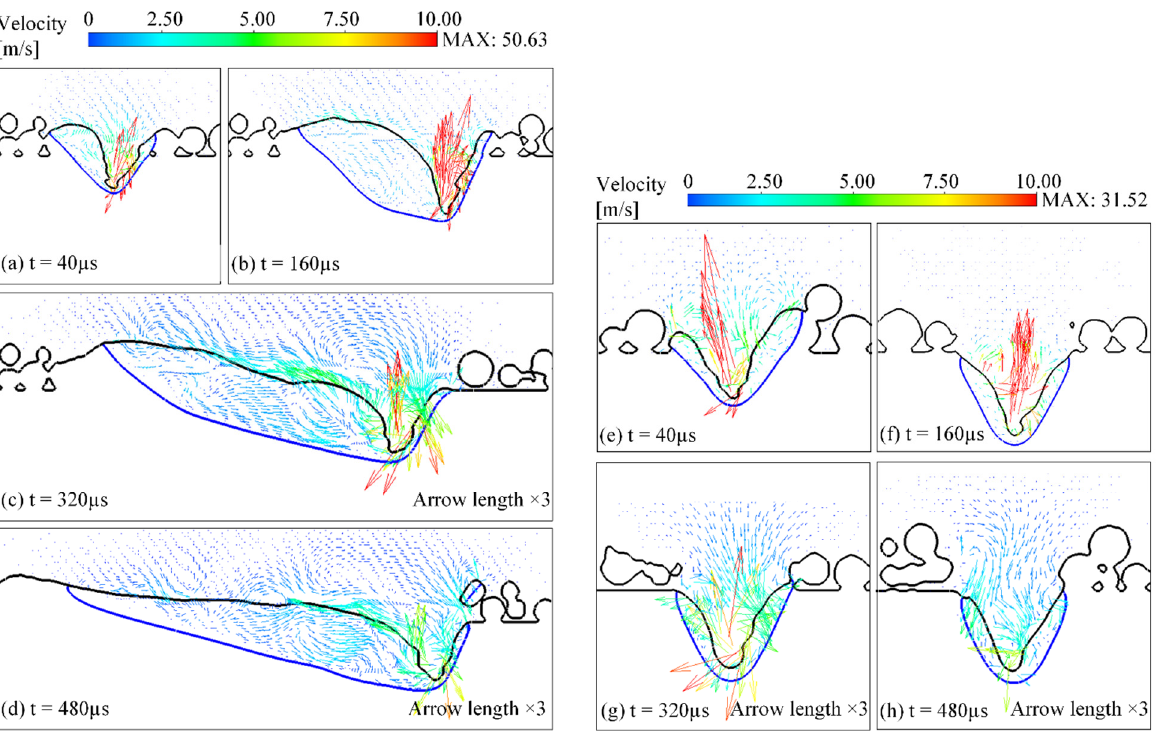
Figure 5. The velocity filed in ( a − d ) the longitudinal section and ( e − h ) the cross-section of the track during the laser scanning, where the blue line represents the boundary of the molten pool. To show the arrows of the velocity field more visibly, the length of the arrows in ( c , d , g , h ) is magnified by 3 times compared with those in the other subfigures ( a , b , e , f ).